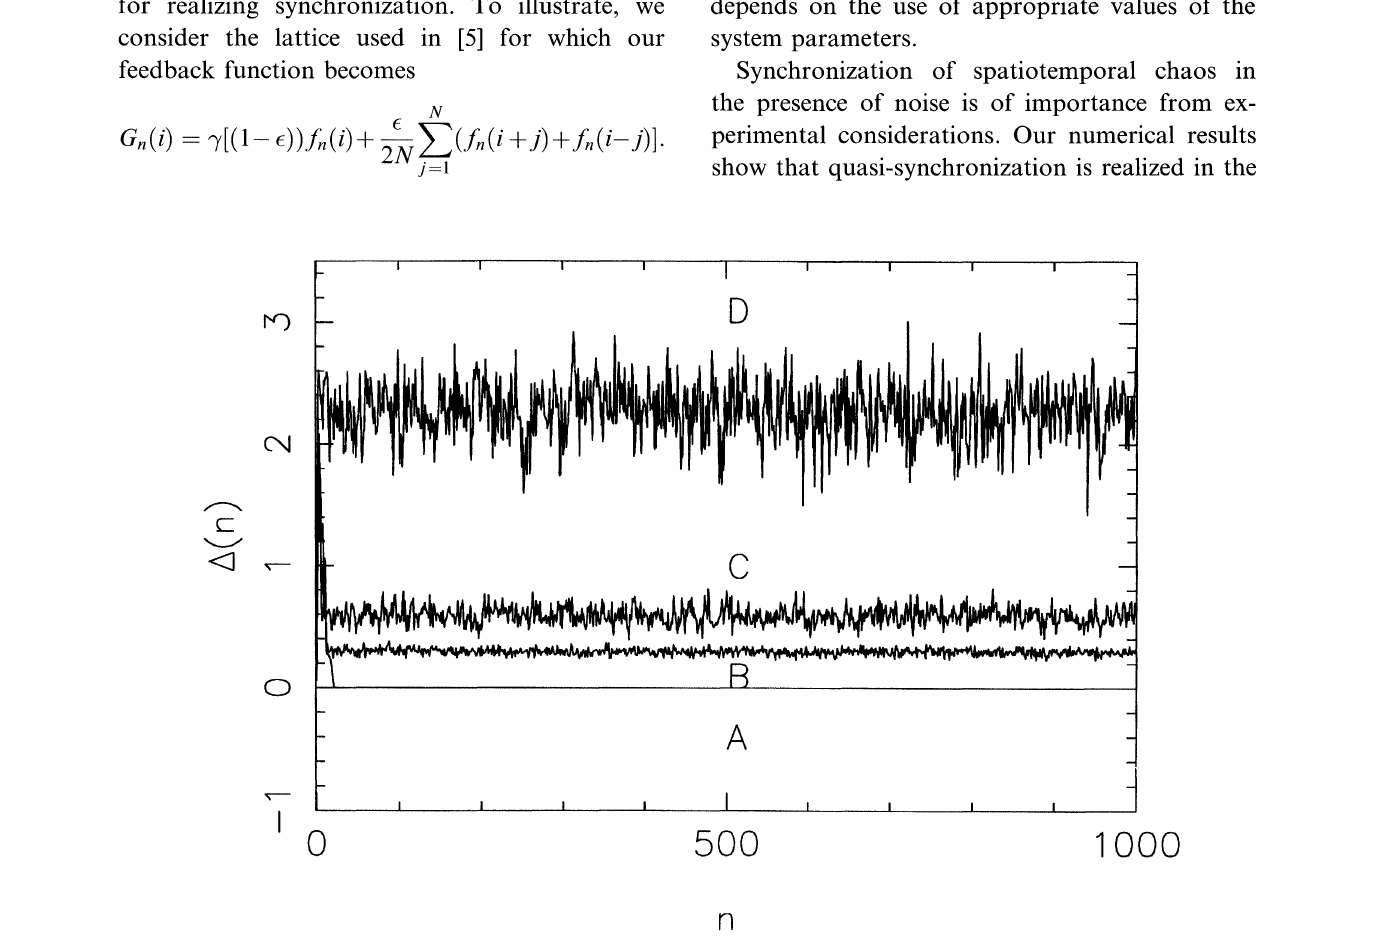
FIGURE 3 Synchronization of a CMLRR using Eqs. (3) and (13) in the presence of noise. Here L 50, u 10, /= 4, 0.1, 0 <_ cij < and two feedback functions, fdl0 and fdl2, corresponding to Eqs. (10) and (12), respectively, are used. In the absence of noise, fdl0 and fdl2 require 12 and 268 iterations, respectively, for synchronization to A(n) < x 10-10. Random numbers Wrlxi and W%,i with 0.05 were added to X,,(i) and Y,(i) at every iteration and every site. For this map, values of > 0.1 quickly result in periodic solutions. Those Wrlxi and Wrlyi were used which resulted in bounded solutions of the map. Curve A corresponds to synchronization with common noise Wrlxi or Wrlyi fed to the driver and response systems. Curves B and C, respectively, correspond to synchronization with the faster fd 10 and slower fd12 when different random numbers WTxi and Wrlyi are fed to the two systems. Curve D is generated without any feedback. A comparison of curves B and C shows that a better synchronization is obtained by a more efficient feedback function when noise is